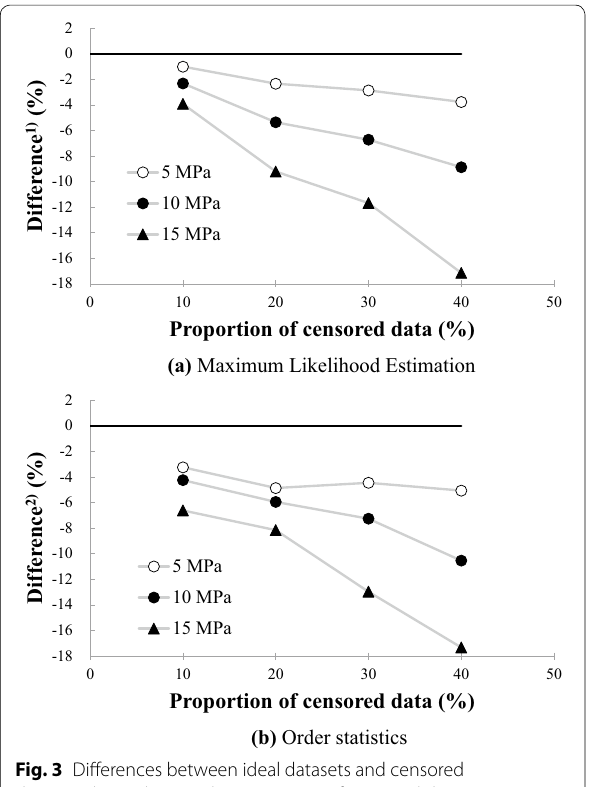
Fig. 3 Differences between ideal datasets and censored (b) Censored Maximum Likelihood Estimation (CMLE) with the lower 30% quantile datasets depending on the proportion of censored data. a Maximum likelihood estimation. b Order statistics. Difference 2 ) = 5% CD,Order − 5% ideal,Order Difference 1 ) = 5% CD,MLE − 5% ideal,MLE 5% CD,Order 5% CD,MLE ,